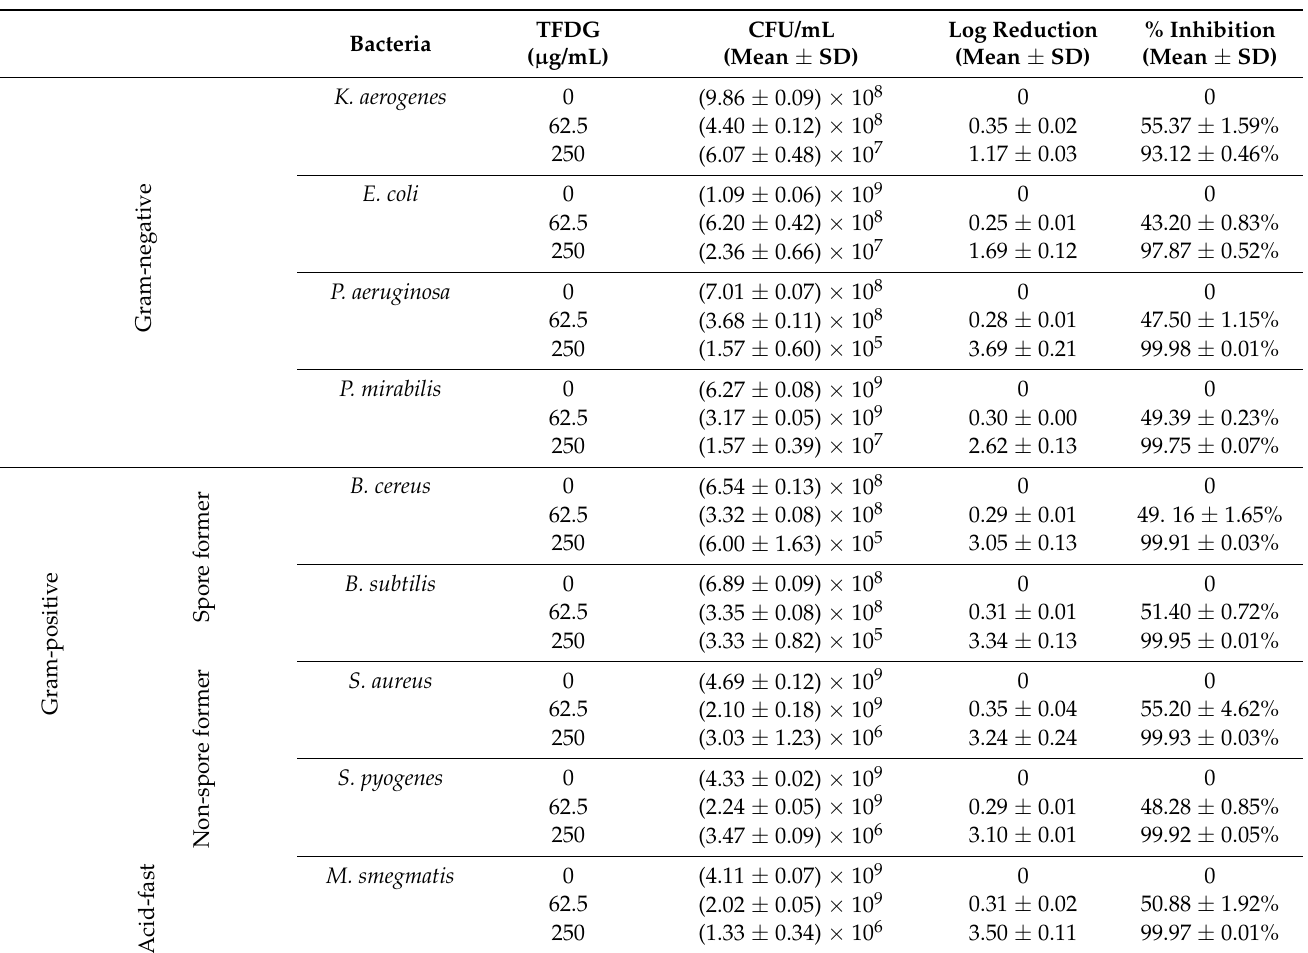
Table 1. Colony-forming unit (CFU/mL) with the log reduction and percent inhibition of different bacteria with TFDG.